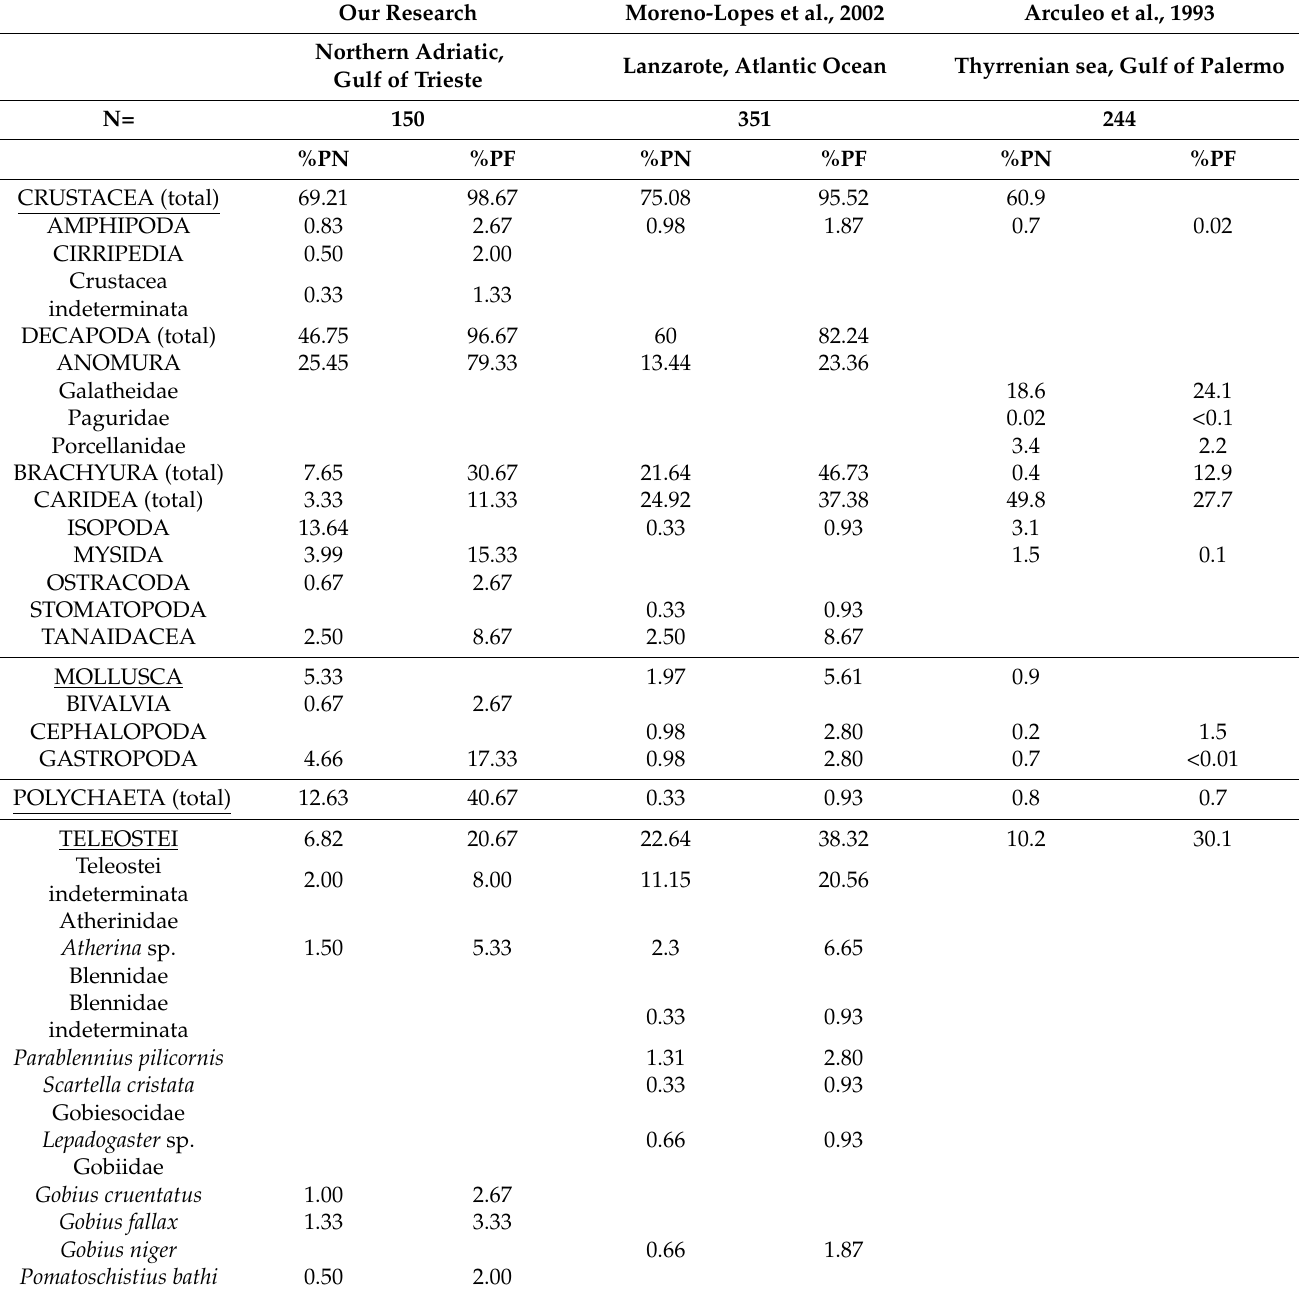
Table 8. Diet of Serranus scriba in various parts of the Mediterranean and Canary Islands (%PN = nu- merical index, %PF = frequency of